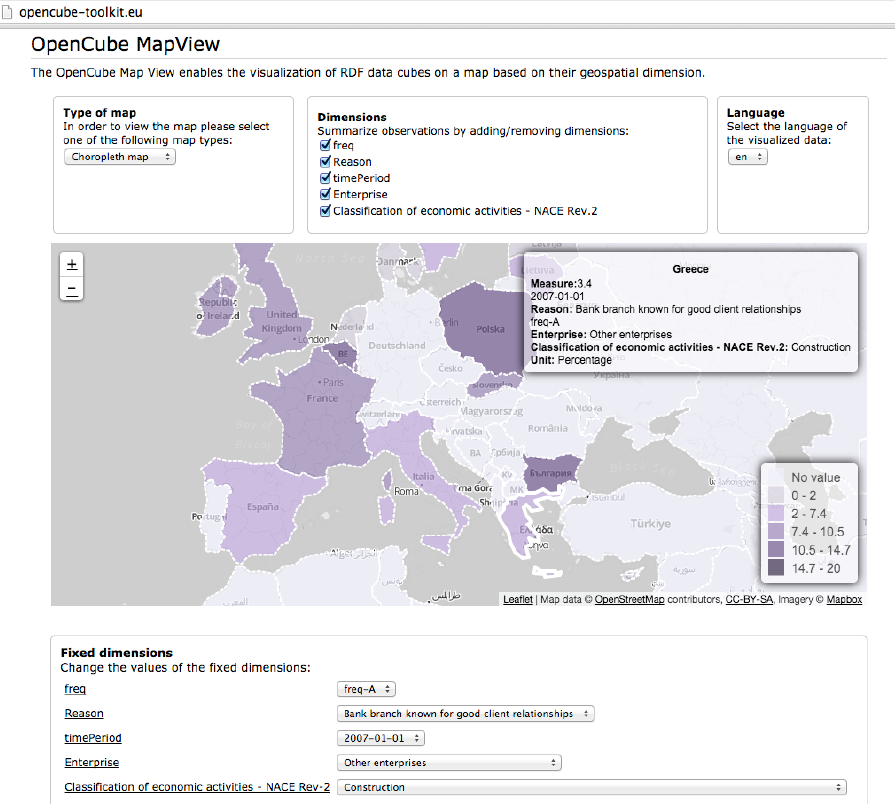
Figure 12: OpenCube